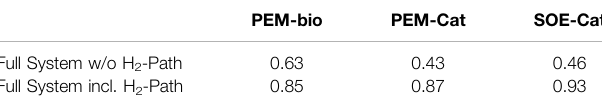
TABLE 5 | Scaling exponents for the considered methanation processes.